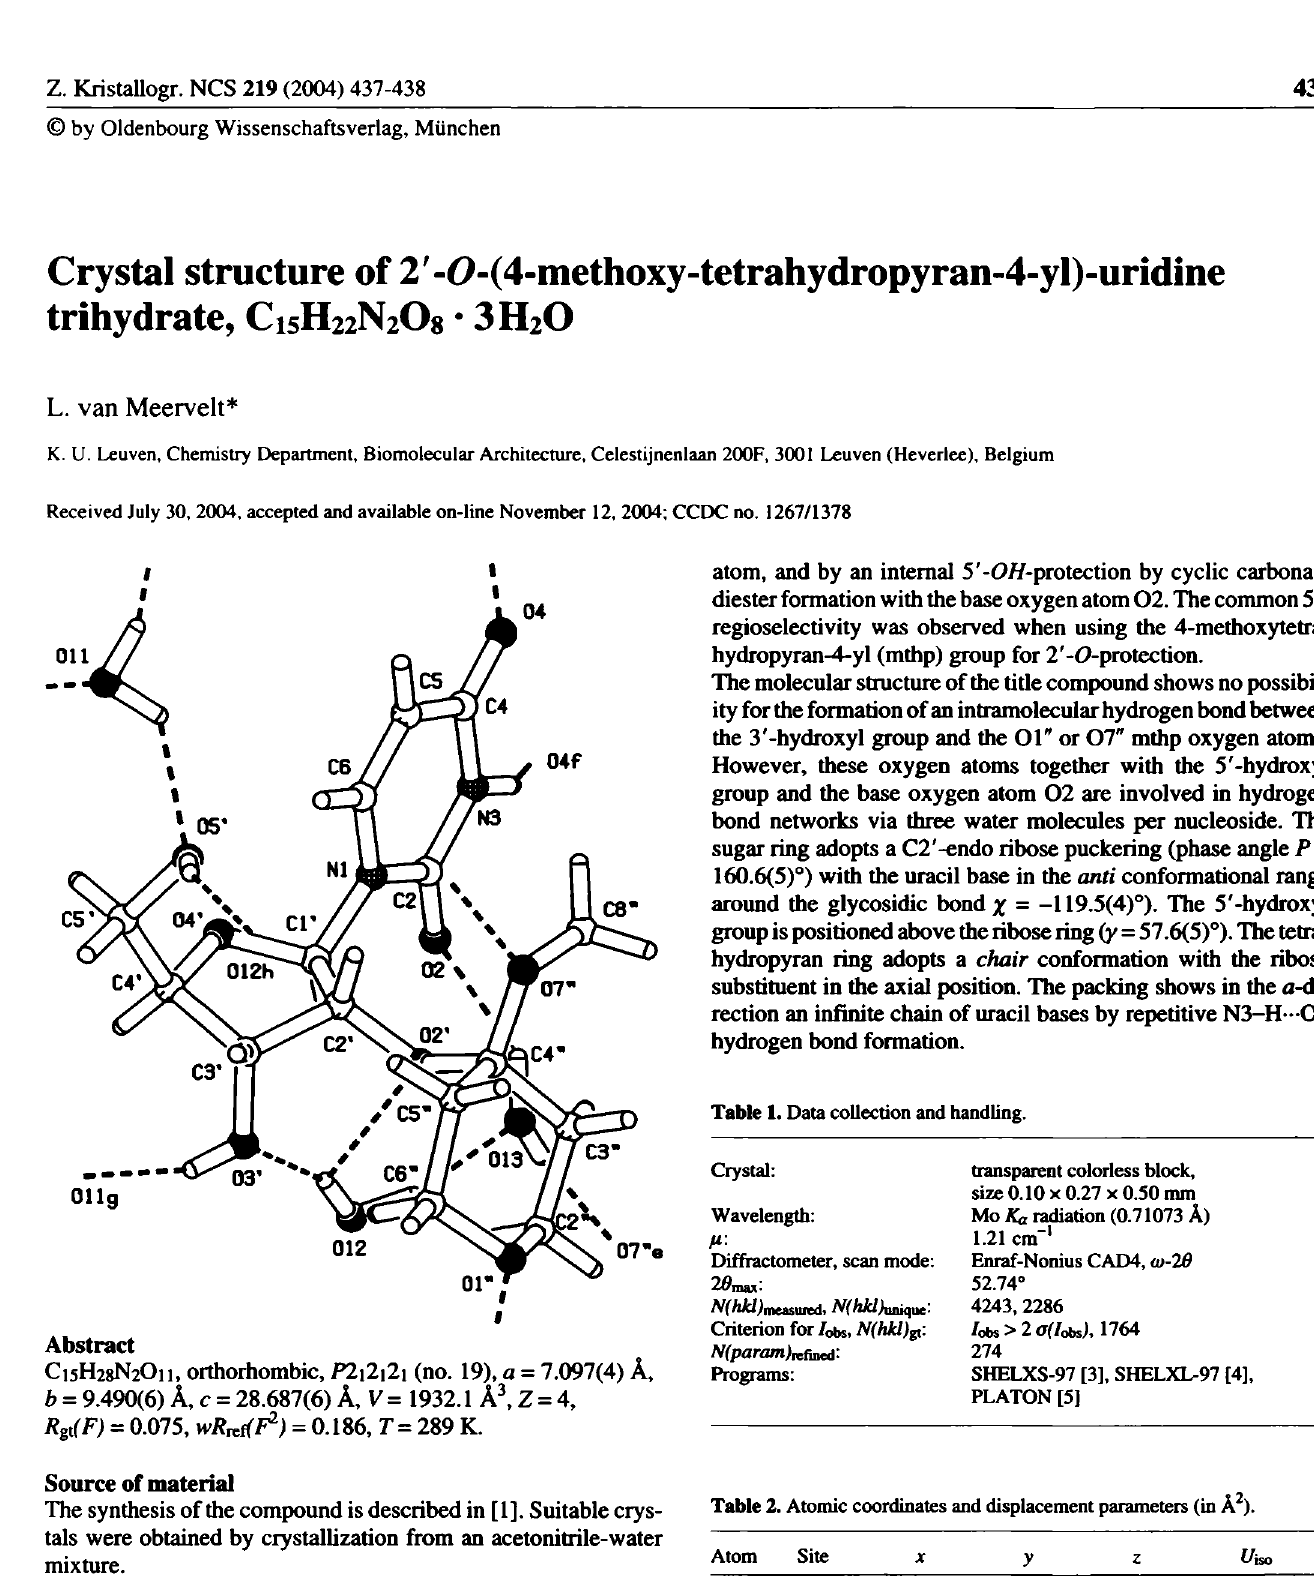
Table 2. Atomic coordinates and displacement parameters (in Â 2